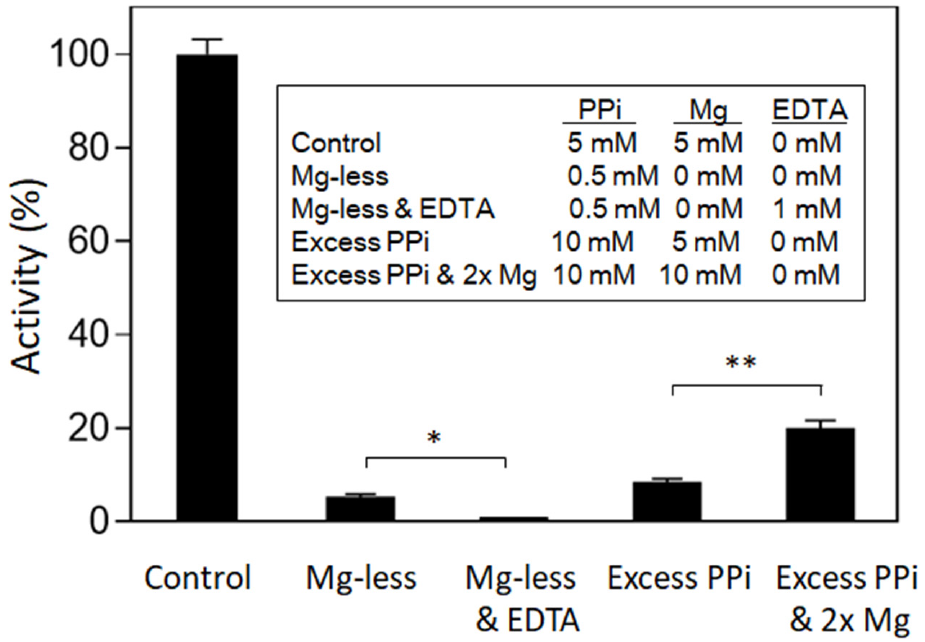
Figure 1. Effects of Mg 2+ and PP i on pyrophosphorolytic activity of barley UGPase. Standard reaction mixture assays (in triplicates) were used, with the exception of varying concentrations of PP i and MgCl 2 (Mg), as indicated. Statistical significance between the samples: * ( p < 0.05); ** ( p < 0.01). To probe in more detail the interactions between the enzyme, magnesium and PP i , the effects of magnesium on UGPase activity were studied kinetically with defined concentra- tions of Mg 2+ and MgPP i . The activity of UGPase versus Mg 2+ followed what appeared to be a typical hyperbolic curve (Figure 2A), consistent with Michaelis–Menten kinetics [24]. This has suggested that magnesium is true substrate of the reaction. However, it was not clear whether it was the result of Mg 2+ binding directly to the enzyme (and serving as cofactor) or binding first to some other ligand(s) and serving as a substrate only in a complexed form (e.g., as MgPP i and/or MgUDPG). When [MgPP i ] was calculated for each of the experimental points and plotted versus observed activity, the resulting plot again appeared hyperbolic (Figure 2C). However, when these data were analyzed using double reciprocal plots for both Mg 2+ and MgPP i , for points corresponding to very low [Mg 2+ ] and [MgPP i ], the double reciprocal plots were nonlinear (Figure 2B,D). Most likely, under these conditions, free PP i inhibited the reaction and, as [Mg 2+ ] increased, the ratio of [MgPP i ]/[PPi free ] also increased, which resulted in relieving the inhibition (the linear portions of the double-reciprocal plots). This was similar to what was observed in Figure 1, where excess of total PP i inhibited the reaction, whereas excess of MgCl 2 increased the activity. The apparent K m values for Mg 2+ and MgPP i , calculated from the linear portion of the double-reciprocal plots were 0.13 and 0.06 mM, respectively (Figure